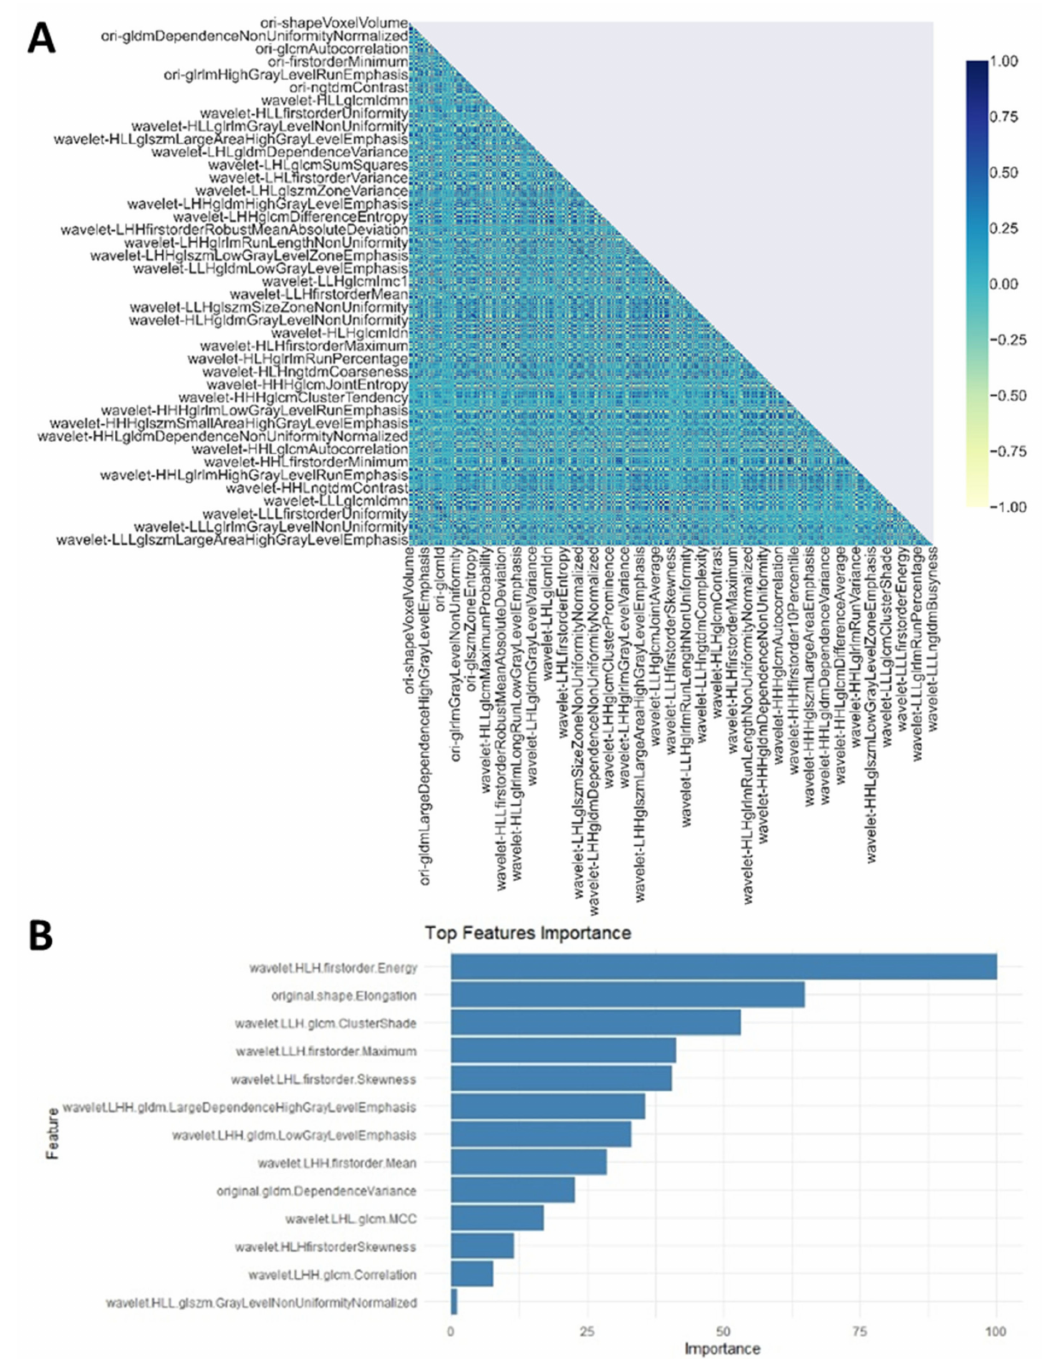
Figure 1. Features’ selection. ( A ) Removing highly correlated features in the training set. ( B ) Thirteen top features selected by LASSO in the training